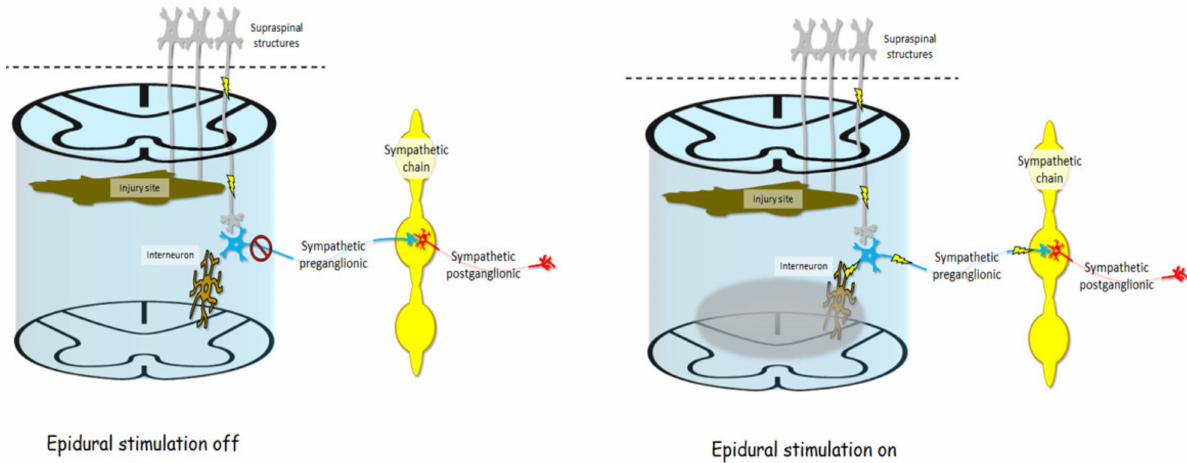
Figure 5. After SCI, axons descending from supraspinal neurons, such as those in the rostral ventrolateral medulla, may be cut off completely by the injury site, or spared connections may exert so little influence at the spinal level that sympathetic preganglionic neurons are dormant and therefore do not exert any influence on the sympathetic chain, and therefore do not influence sympathetic postganglionic neurons or organs subserving cardiovascular functions. Electrical fields delivered by epidural stimulation (gray bubble) may indirectly influence multi-segmental interneurons via dorsal root afferents (not